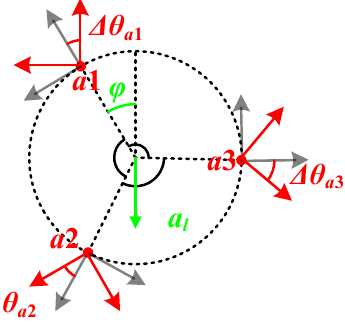
Figure 4. Description of the attitude error.